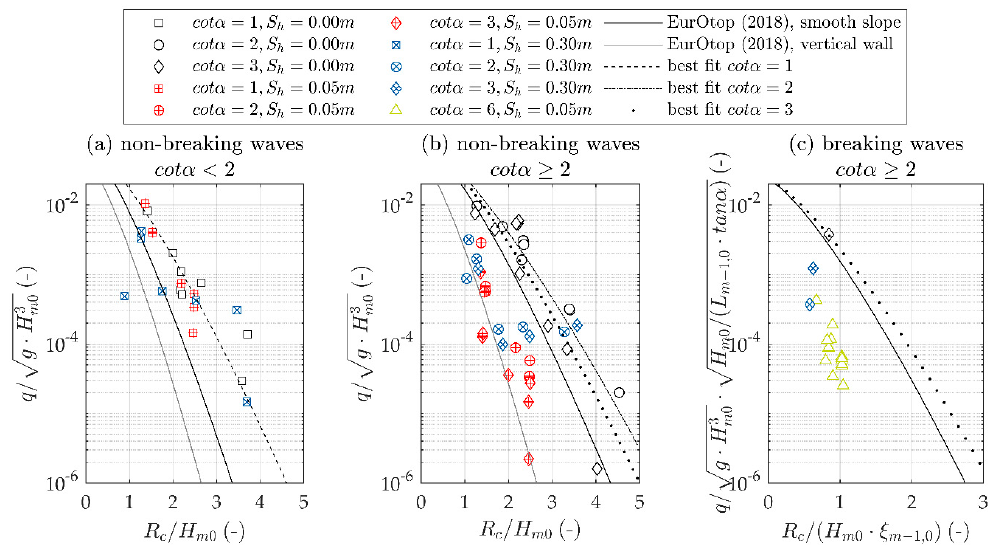
Figure 2. Dimensionless overtopping discharge over the dimensionless freeboard height for smooth and stepped surfaces with different slope angles. Overtopping prediction formulae according to EurOtop (2018) [13] for smooth slopes and vertical walls are given as reference. Determined best fits for smooth slopes of the present study are given for ( a ) steep slopes with cot α < 2 and non-breaking wave conditions, ( b ) milder slopes with cot α ≥ 2 and non-breaking wave conditions and ( c ) mild slopes with 𝑐𝑜𝑡𝛼 ≥ 2 and breaking wave conditions.